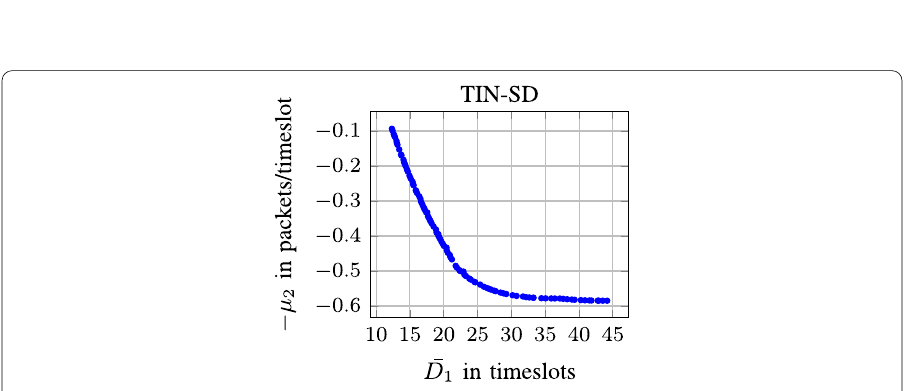
Fig. 11 Pareto set for (19) in TIN-SD. The rest of the parameters are the following: (cid:31) 1 = 0.1 , γ 1 = − 4.2dB , γ 2 = − 6.4dB , α = 2.2 , β = 41dB , P J = 23dB , B = 6 packets, P max = 23dB , d 2 = 14.6m , and d 12 = 10m . In TIN-SD, d 1 =